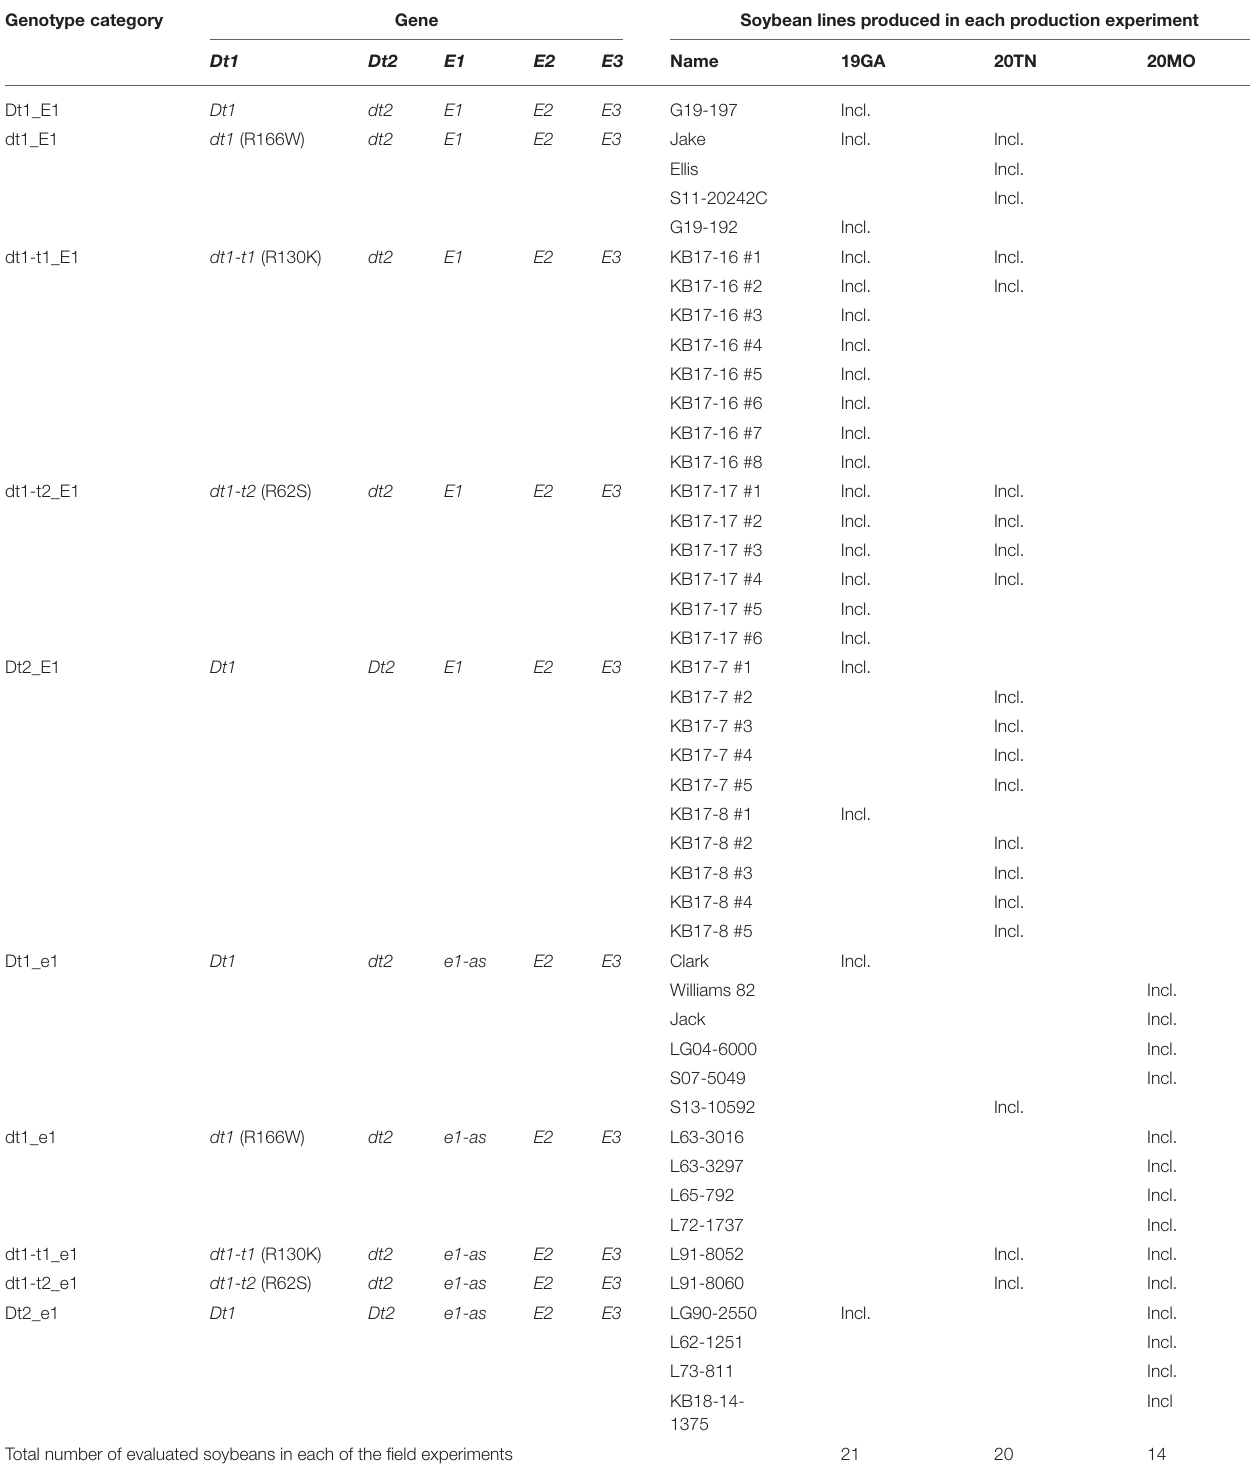
TABLE 2 | Allele combination of experimental and control lines used for field experiments in three different environments. Genotype